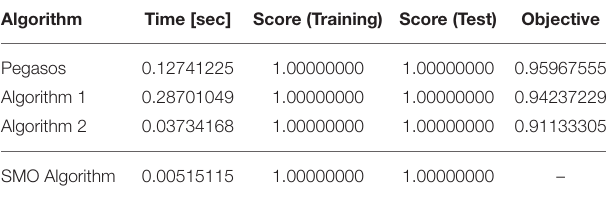
TABLE 4 | Iris (multiclass; Algorithms 1, 2, and 5 are used as solvers for the subproblem appearing in this multiclass classification experiment).